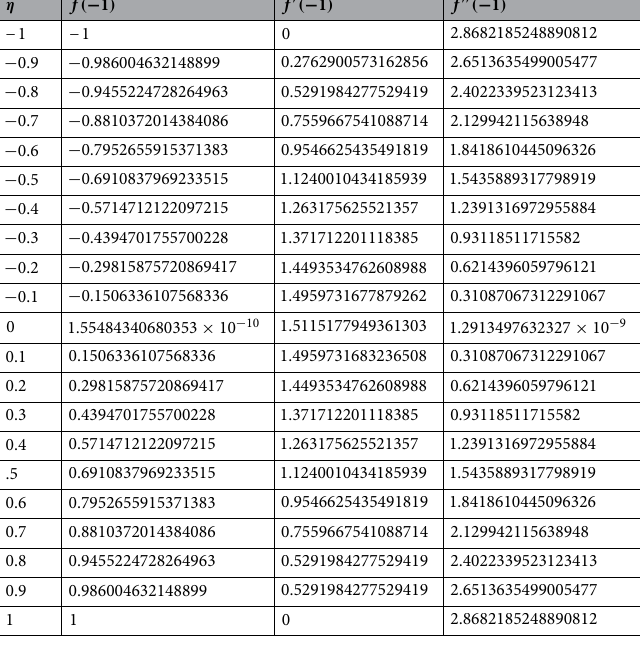
Table 10. Data for the Numerical